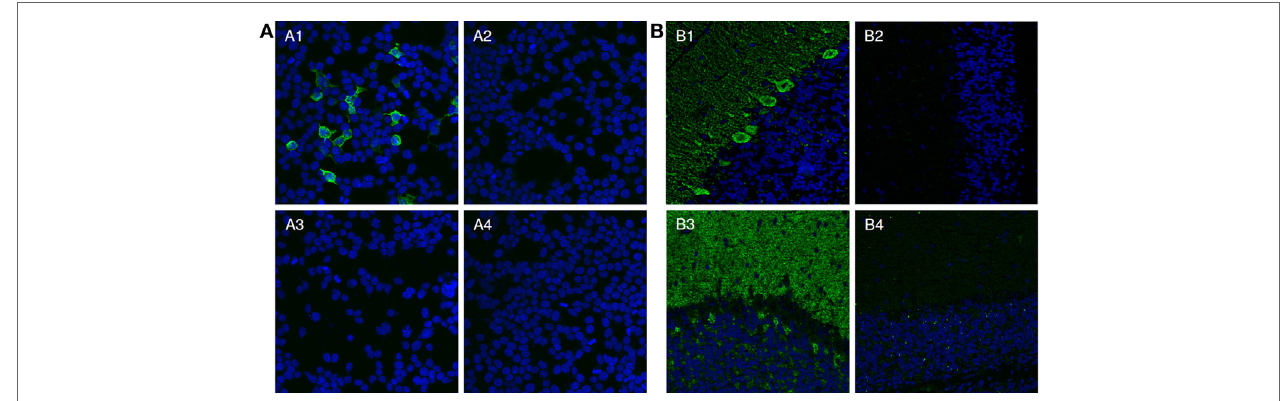
FigUre 4 | Verification of identified antigens by indirect immunofluorescence. (a) Indirect immunofluorescence analysis of transfected HEK293 cells. Acetone-fixed recombinant HEK293 cells expressing the protein of interest (1, 3) or a mock-transfected control (2, 4) were incubated with patient serum (1, 2) or with control serum (3, 4) (both 1:1,000). Cell nuclei were counterstained with TO-PRO-3 iodide (blue). Only HEK293-expressing the protein of interest reacted with the patient sera (green). (B) Two examples for the neutralization of immunofluorescence reaction on neuronal tissues. Serum 1 and 2 (green) were pre-incubated with extracts of HEK293 cells transfected with empty control vector (1, 3) or the plasmid harboring the cDNA of interest and analyzed in an indirect immunofluorescence assay with rat cerebellar cryosections (2, 4). The extract containing the protein of interest greatly reduced or abolished the immune reaction of the serum on rat cerebellum (2, 4). The control extracts had no effect (1, 3). Nuclei were counterstained by incubation with TO-PRO-3 iodide